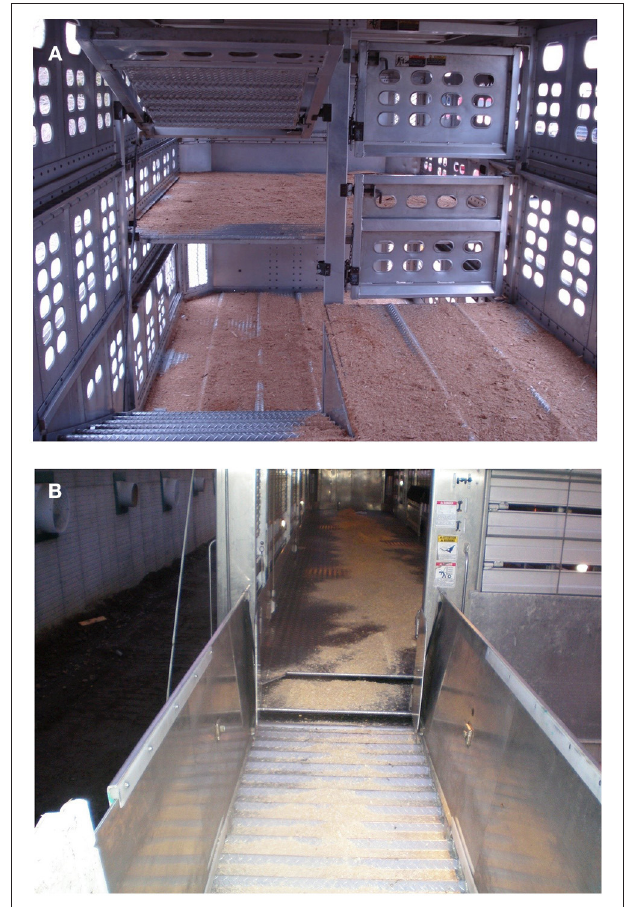
FIGURE 2 | Inside view of: (A) “pot belly”; and (B) flat deck trailer (Dr Luigi Faucitano, Agriculture and Agri-Food Canada).